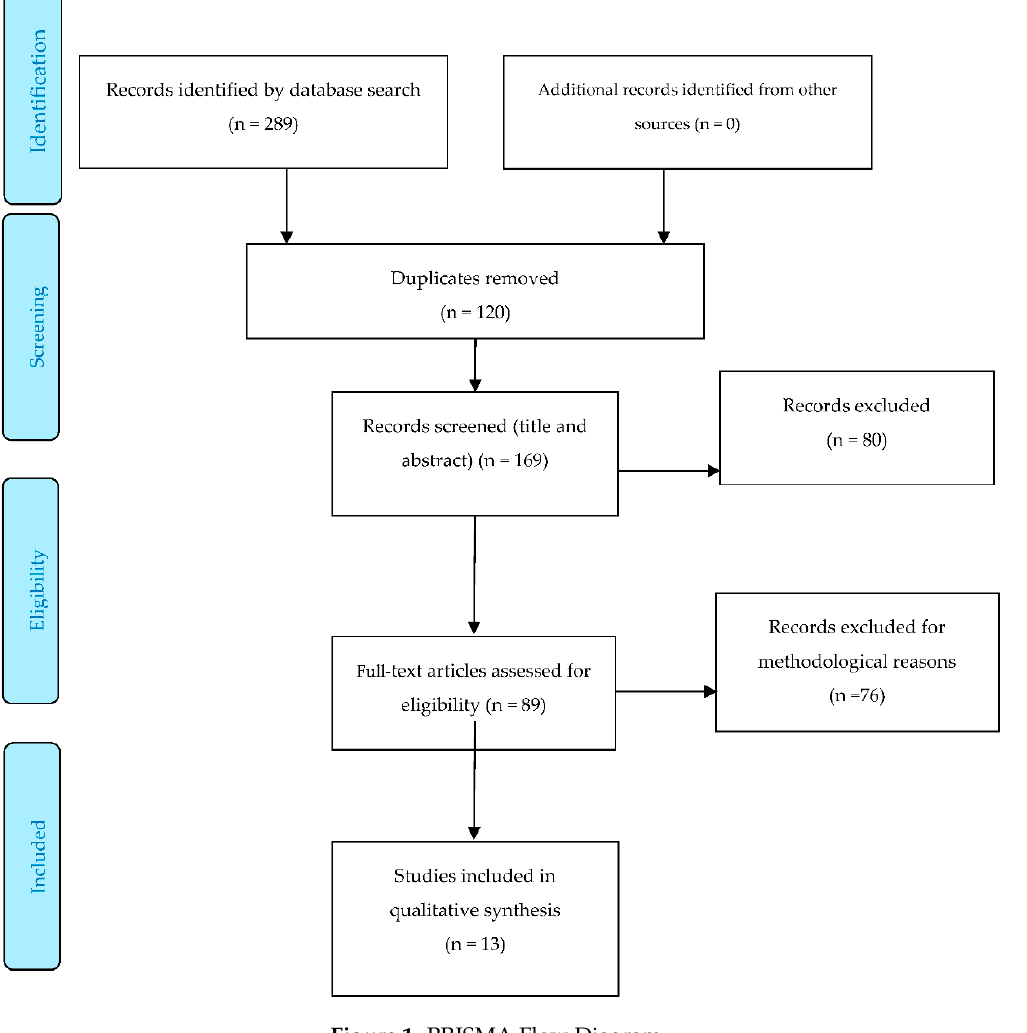
Figure 1. PRISMA Flow Diagram.